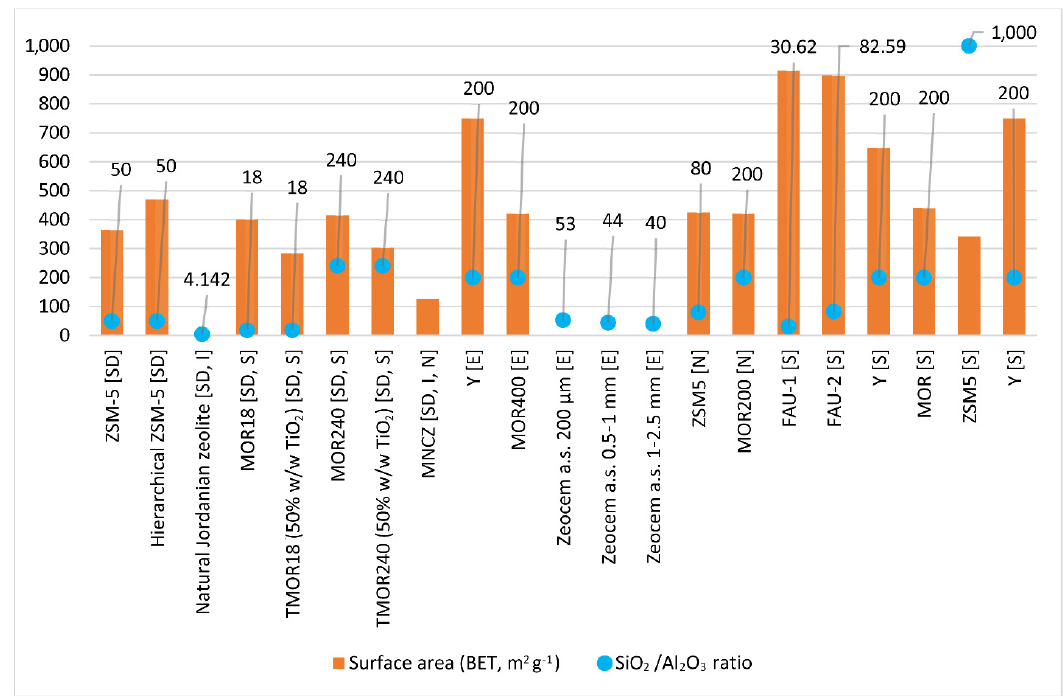
Figure 3. Structural properties of zeolites described in the literature for the removal of selected NSAIDs ([SD]—sodium diclofenac, [I]—ibuprofen, and [N]—naproxen) and selected antibiotics ([E]—erythromycin and [S]—sulfamethoxazole), ZSM-5 [SD], hierarchical ZSM-5 [SD]—[157]; natural Jordanian zeolite [SD, I]—[159] MOR18 [SD, S], TMOR18 (50% ( w / w )